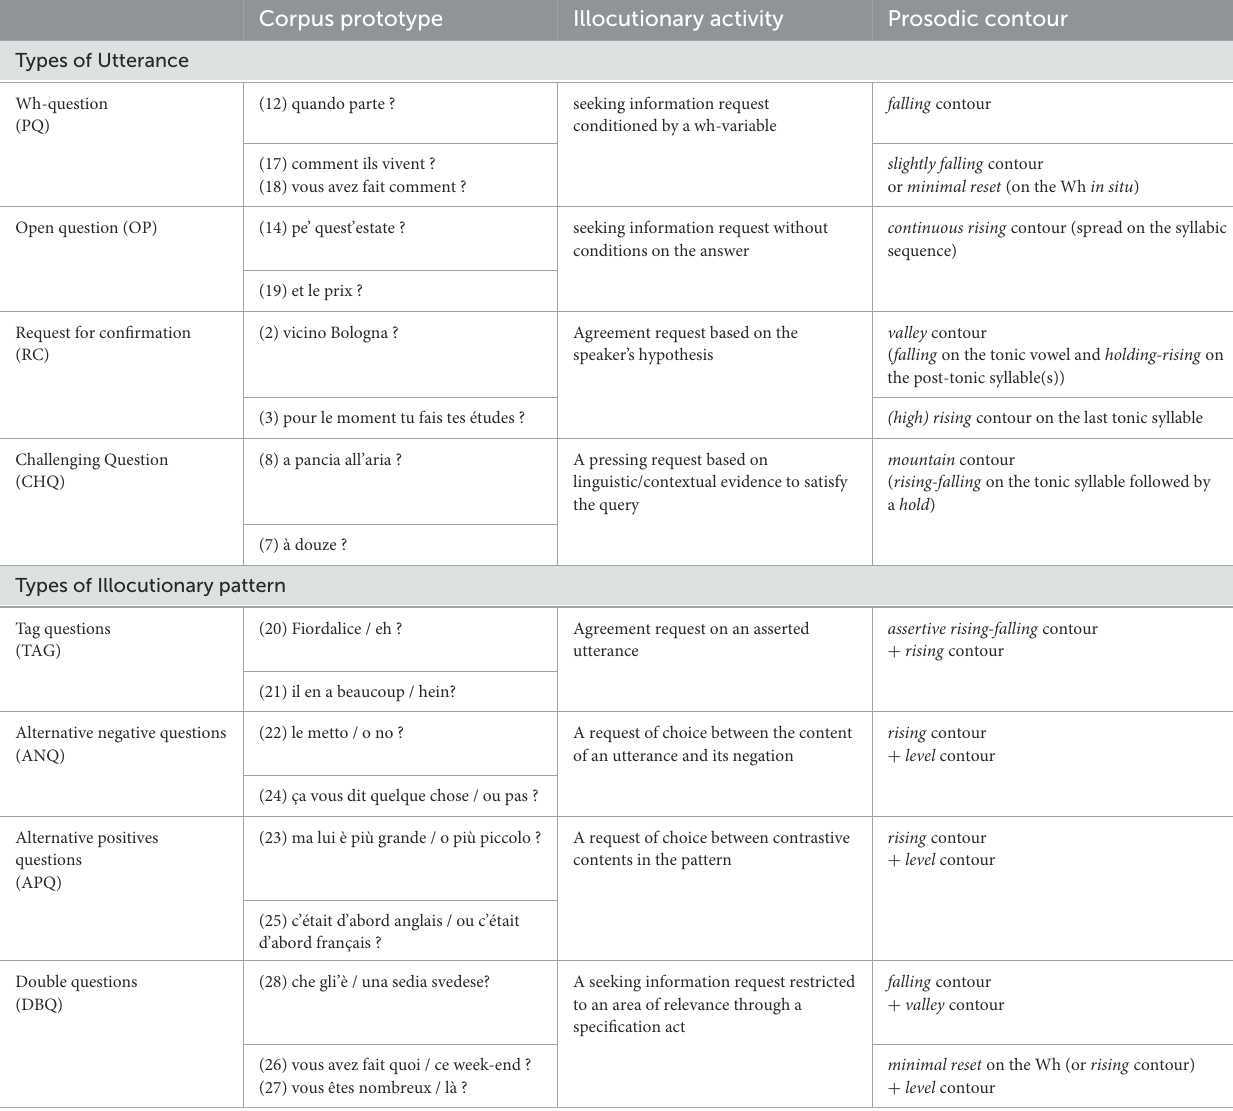
TABLE 4 The system of Requests aimed at the addressee’s linguistic behavior in Italian and